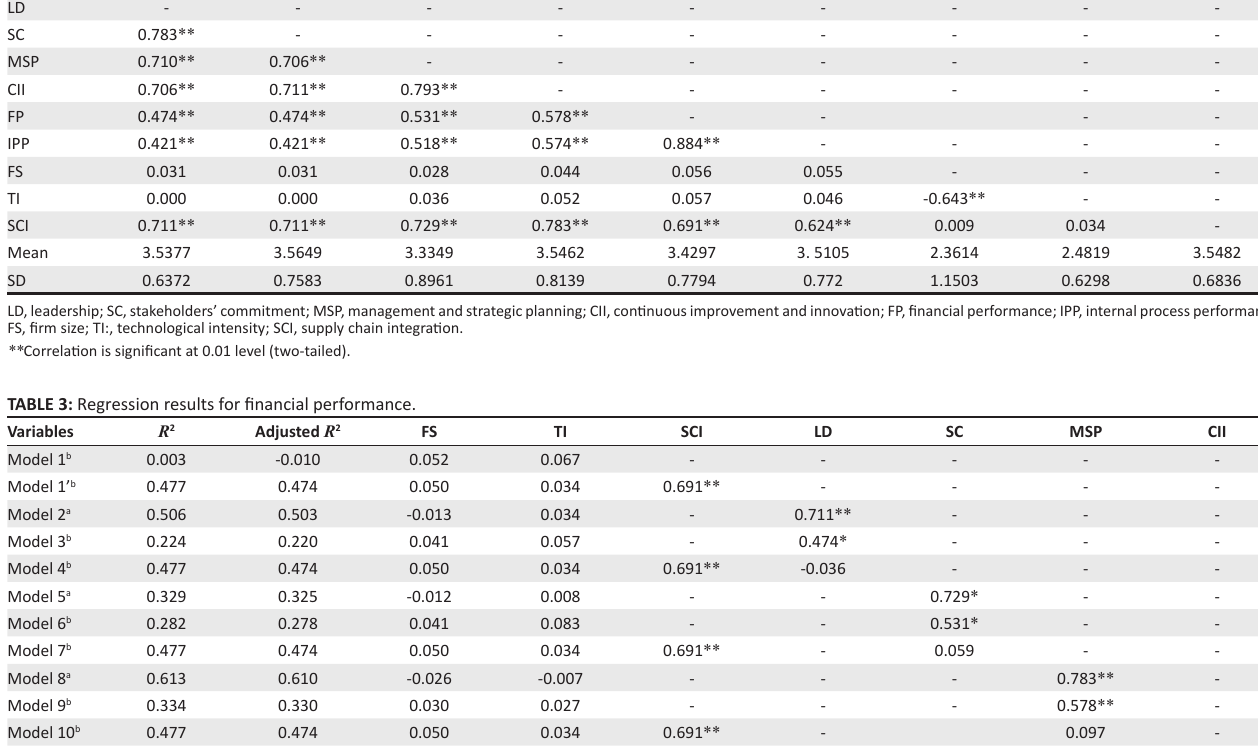
TABLE 2: Descriptive statistics and correlation of supply chain management practices, supply chain integration and firm performance. Variables